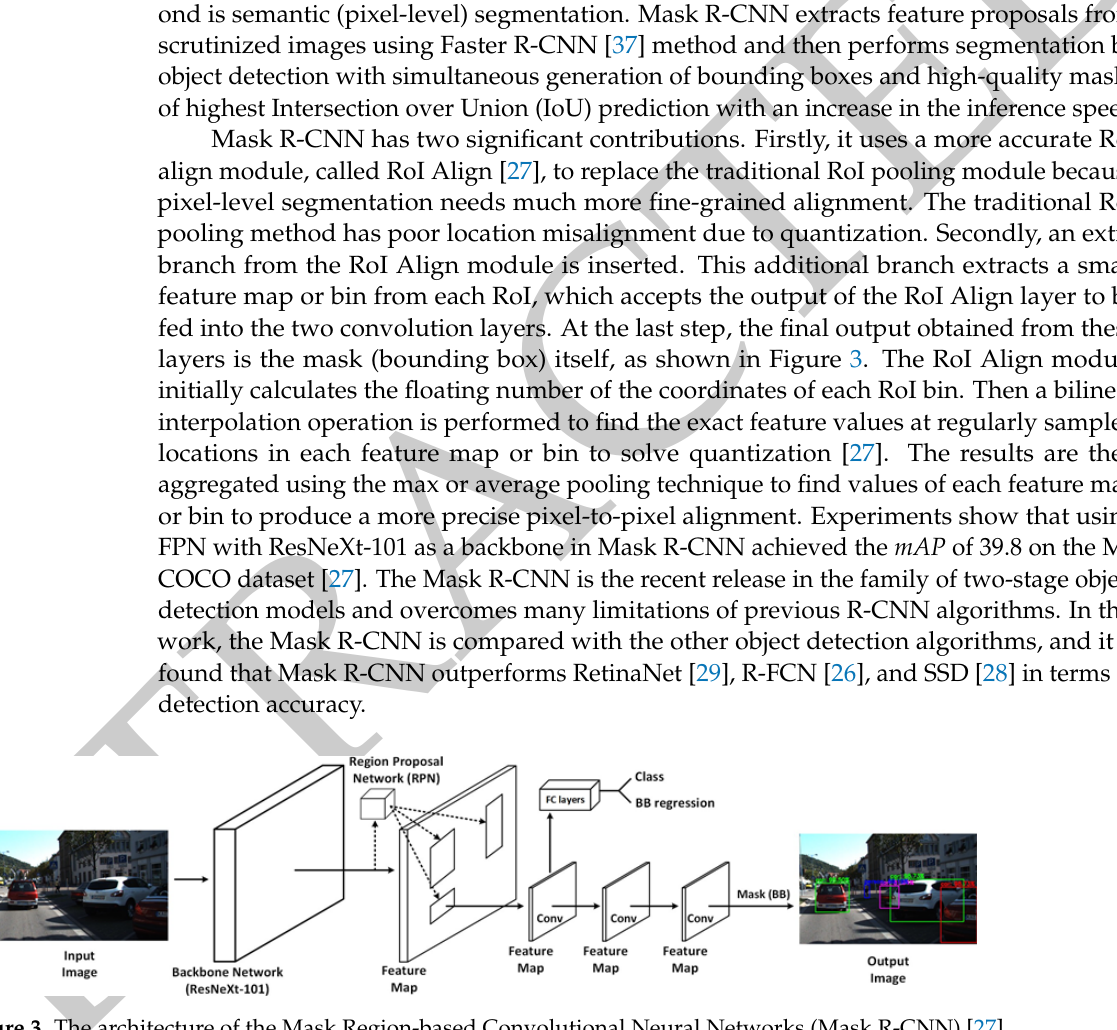
Figure 2. The architecture of the Region-based Fully Convolutional Networks (R-FCN) [26] . Mask R-CNN